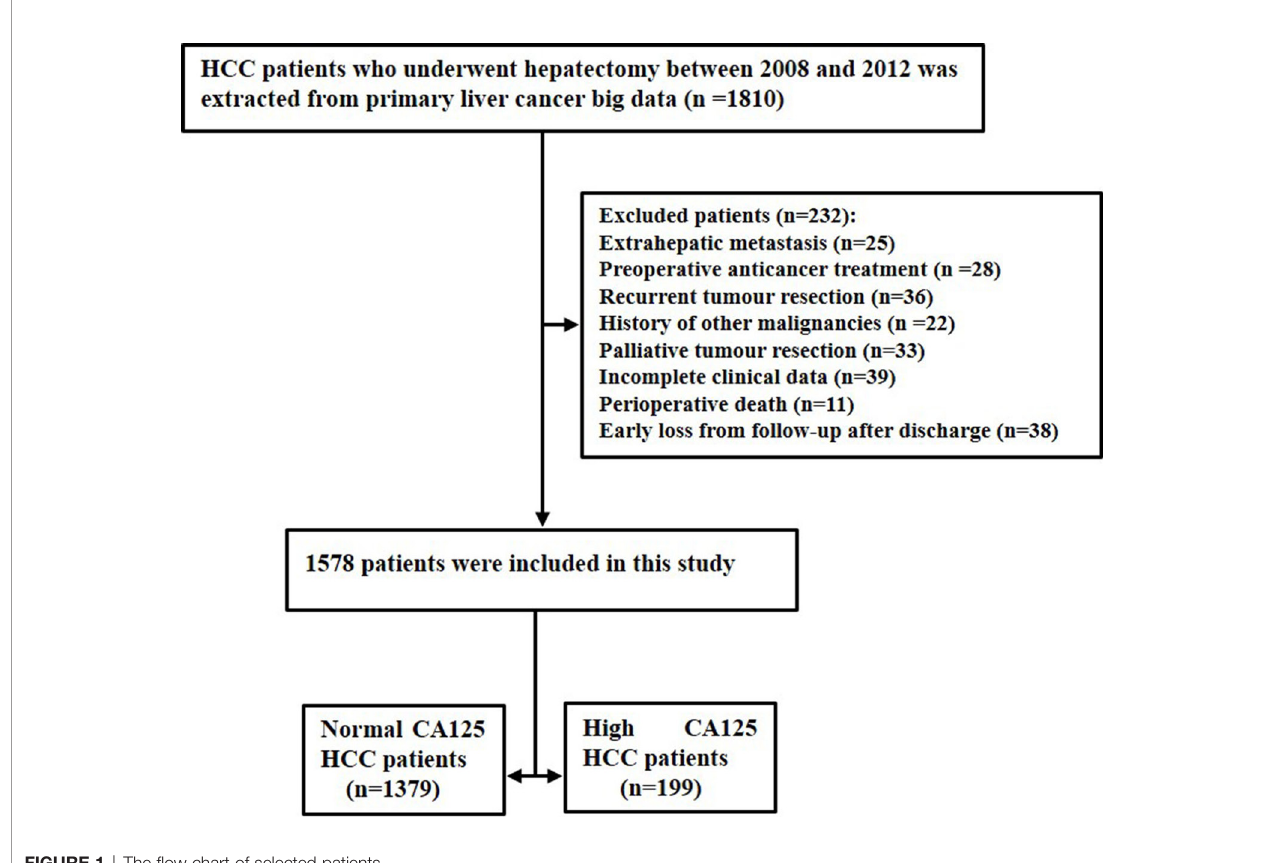
FIGURE 1 | The fl ow chart of selected patients.